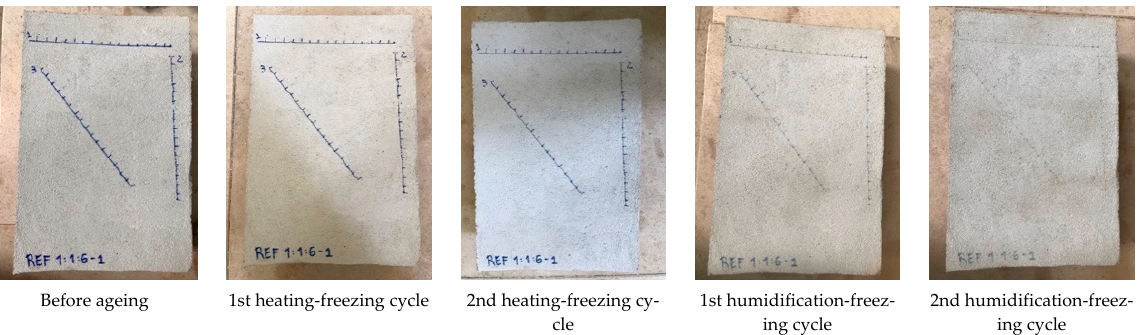
Figure 14. Visual aspect of the reference cement-lime mortar during the artificial ageing test.